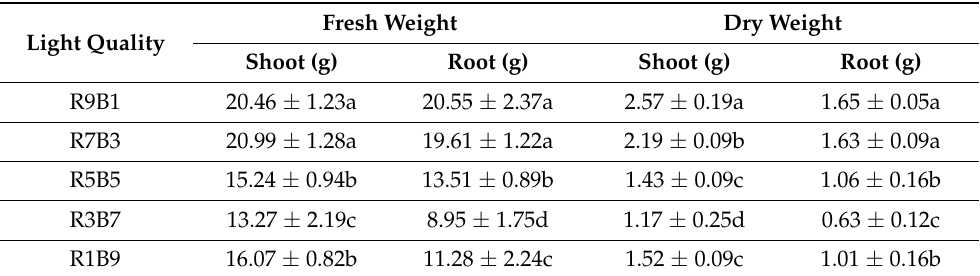
Table 2. Dry weight and fresh weight of cucumber seedlings at 19 days (2022/9/19) after sowing. Values are means ± standard errors. Means with the same letter within each column were not significantly different at p <